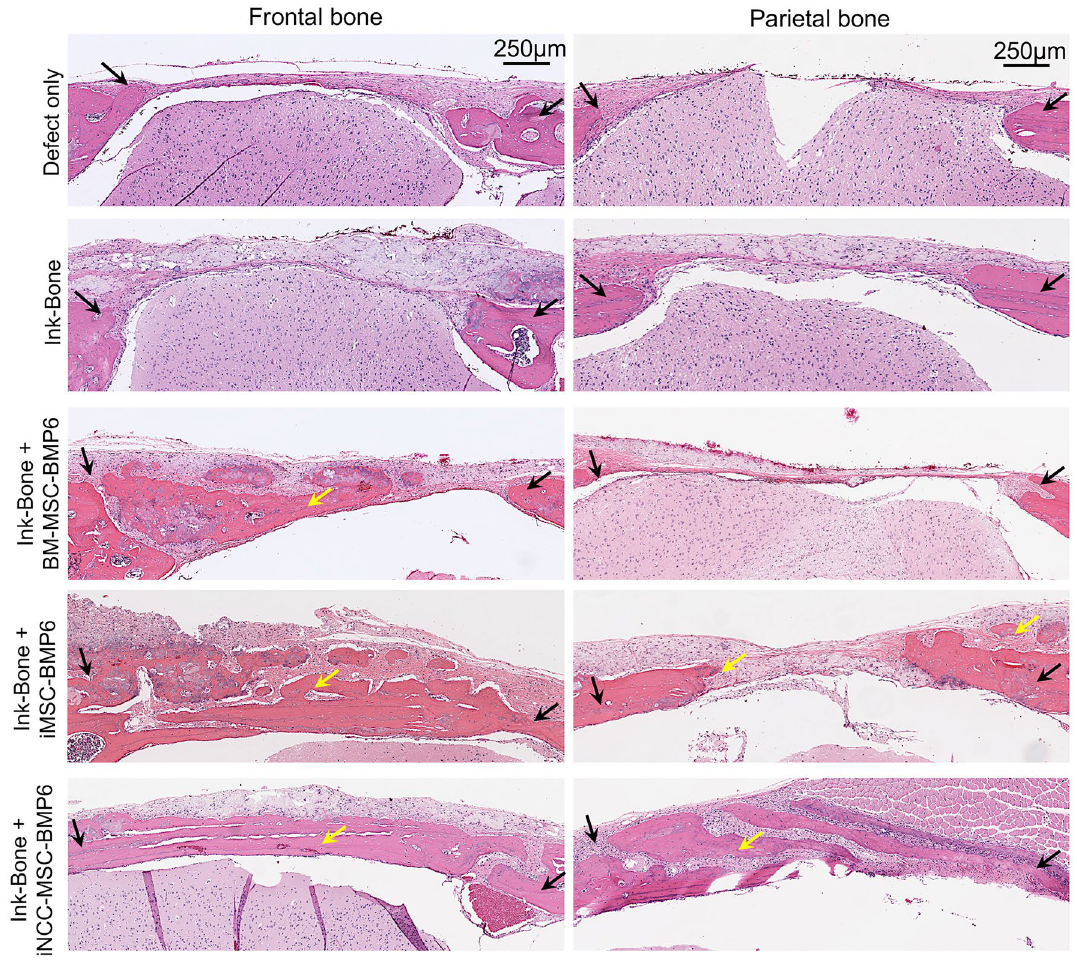
Figure 6. Histological evaluation at week 8 demonstrates increased new bone formation in frontal bone defects treated with Ink-Bone + iNCC-MPC-BMP6. Shown is the H&E staining of the frontal bone defects treated with the different experimental groups. Black arrows: edges of defect site, yellow arrow: new bone